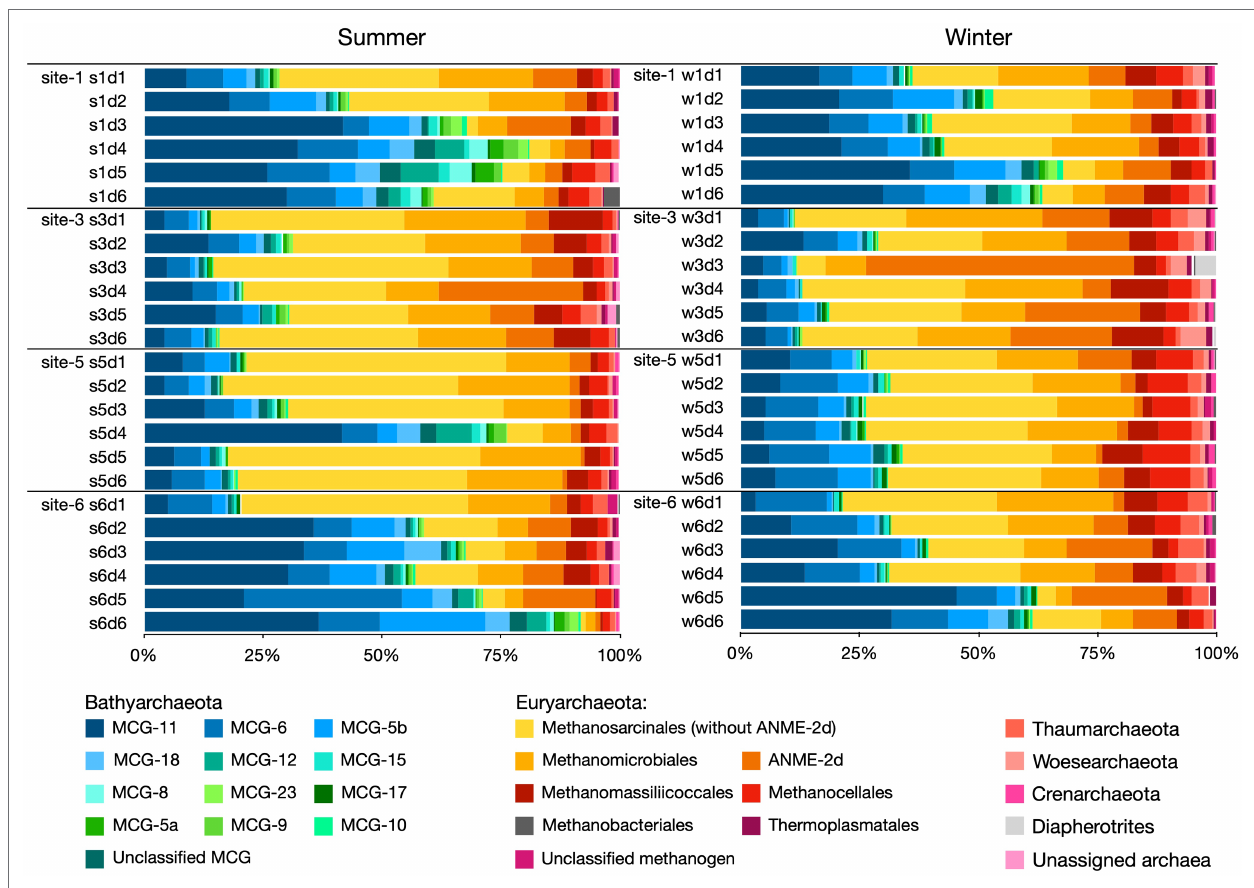
FIGURE 4 | Archaeal taxonomic community compositions in different samples as revealed by 16S rRNA gene